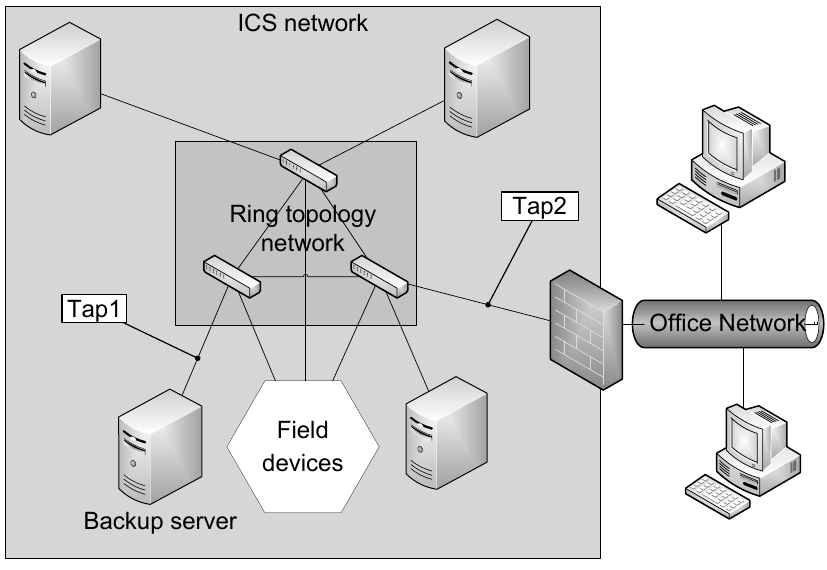
Figure 1. Overview of the network structure of the factory